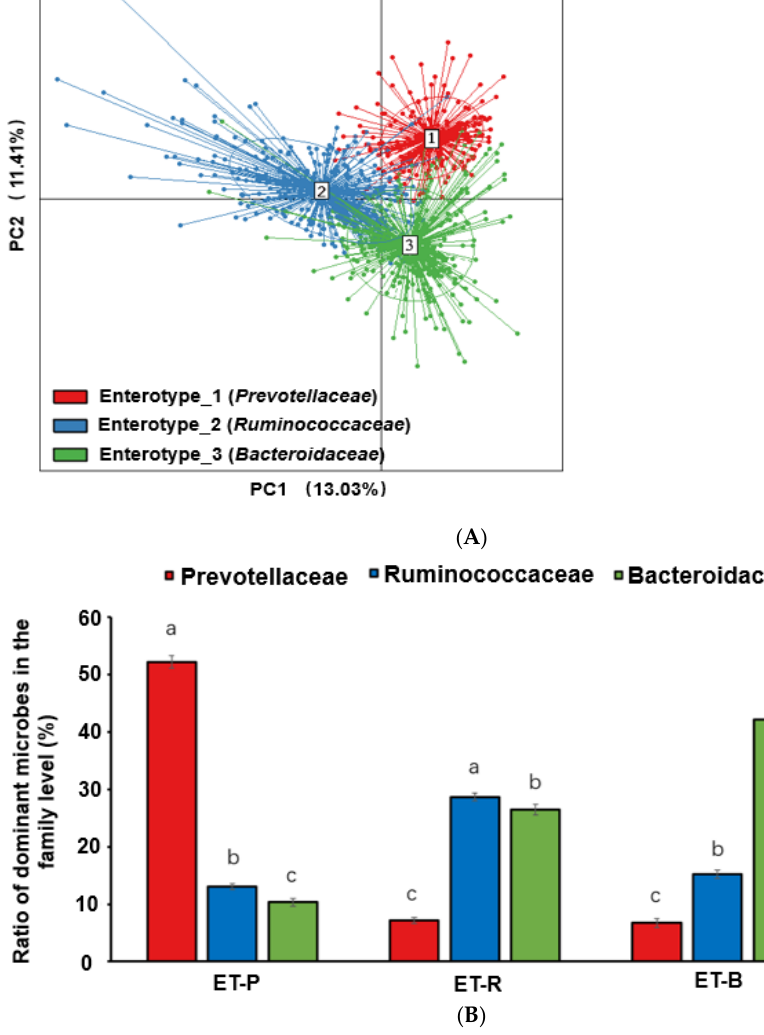
Figure 2. The classification of fecal bacteria and the dominant fecal bacteria in the family level according to each enterotype. ( A ) Enterotypes in the genus level by principal component analysis. ( B ) The relative proportions of dominant bacteria in the family level. Different alphabets (a,b,c) indicated significant differences among the different bacteria in the family level by Tukey’s test at p <